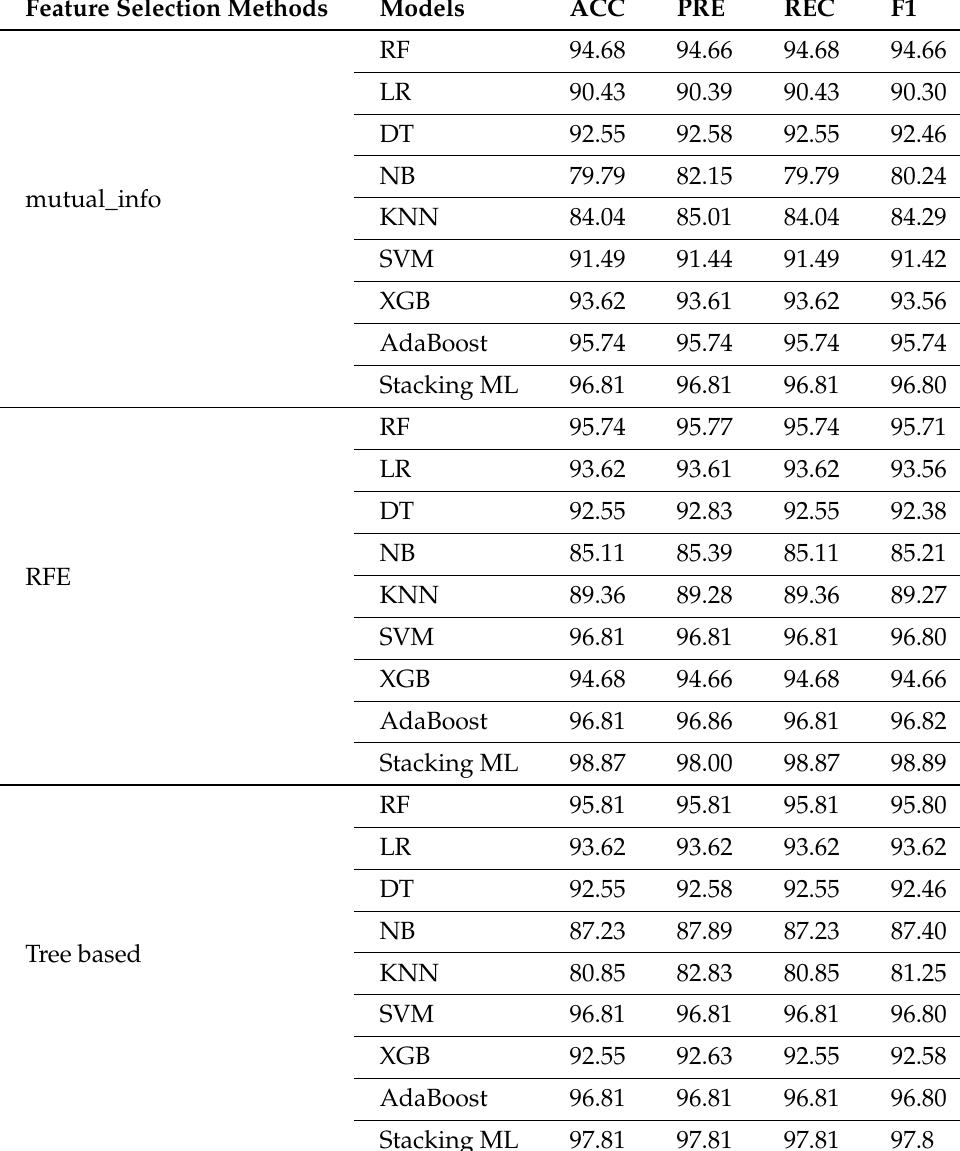
Table 3. Performance of the classifiers with selected features using splitting